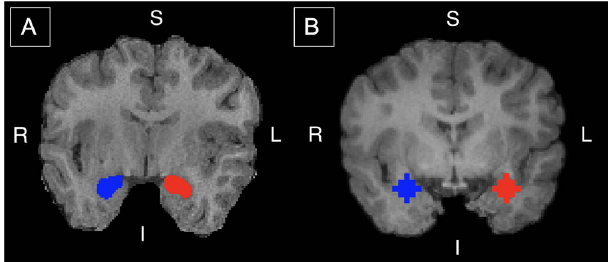
Figure 4. Amygdala segmentation and regions of interest. ( A ) Segmentations of the right (blue) and left (red) amygdala. Segmentations of each participant’s brain were obtained from raw T1 images with Multi-atlas Cortical Reconstruction Using Implicit Surface Evolution (MaCRUISE) software and were used to analyze the relationship between maternal anxiety and child amygdala volume. ( B ) Amygdala seed regions used in the functional connectivity analysis. Regions are overlayed on a T1 image registered to a pediatric brain template in standard space. Seed regions were defined with a 6 mm radius sphere centered at − 25, 1, − 18 (red; left amygdala) and 26, 1, − 18 (blue; right amygdala). Coordinates were obtained from the Automated Anatomical Labeling atlas (AAL). S—superior; I—inferior; R—right; L—left. The segmentations and regions of interest are displayed on the same